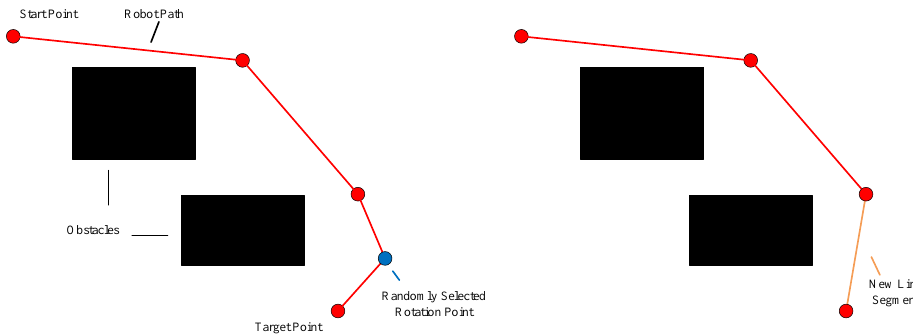
Figure 5. The shortness operator is presented. In the sub-figure on the left, a rotation point (indicated by a blue circle) on the path is randomly selected and removed. Then the new path is shown in the right sub-figure.